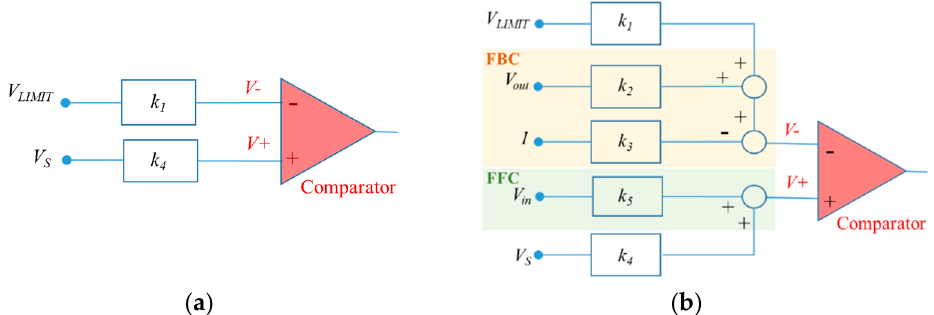
Figure 6. Control block diagrams of the traditional peak current mode control PWM ( a ) and the proposed CPC-PWM ( b ).